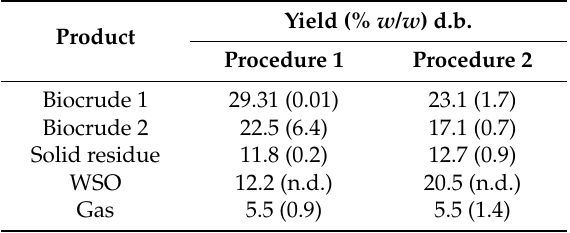
Figure 3. Effect of the collection procedure on biocrude 1 composition by GC-MS analysis ( a ) and on aqueous phase composition by HPLC analysis ( b ) The experiment was performed at 350 °C, 10 min, 10%. Table 4. Effect of the collection procedure on measured yields of products—experiment performed at 350 ◦ C, 10 min, 10%. Absolute standard deviation is given in